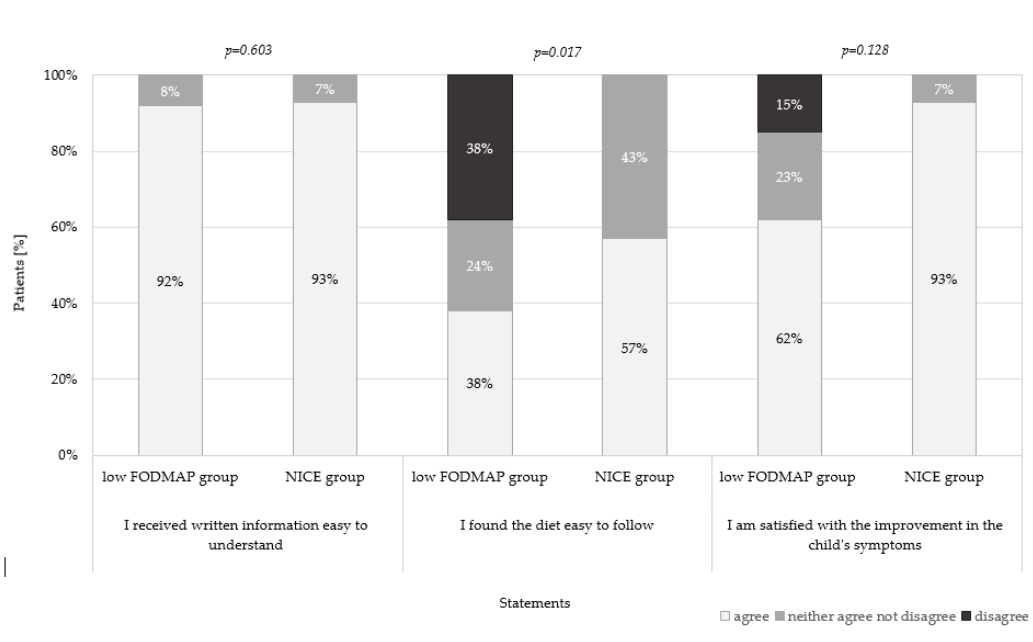
Figure 3. Parental agreement with opinion statements about the received diet.